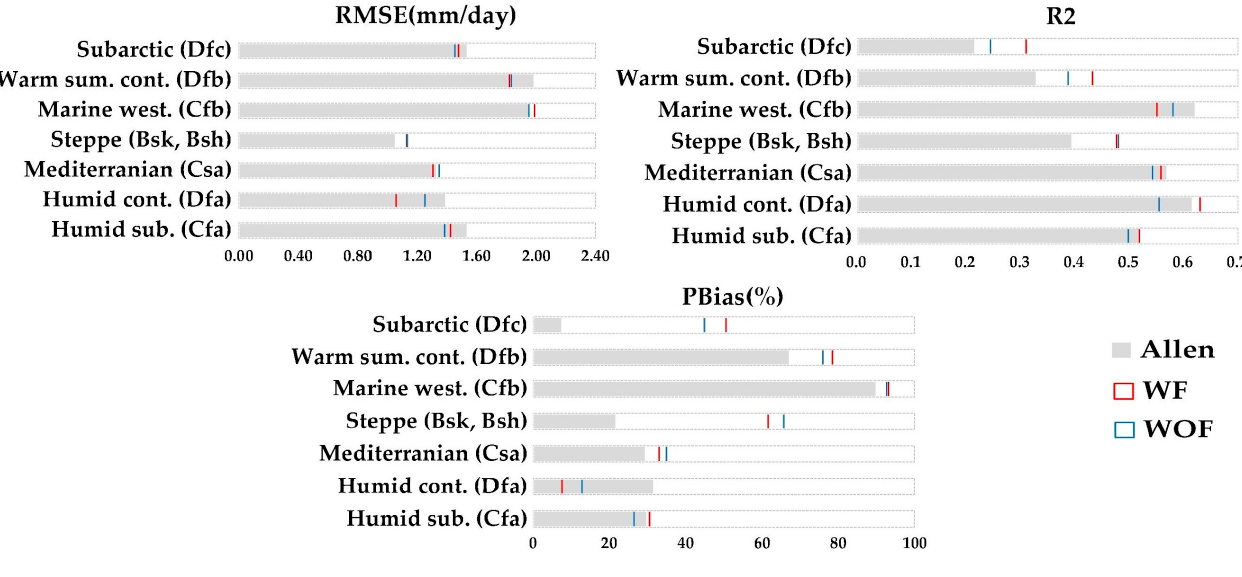
Figure A4. Evaluation of endmember selection procedures based on Köppen climate types.